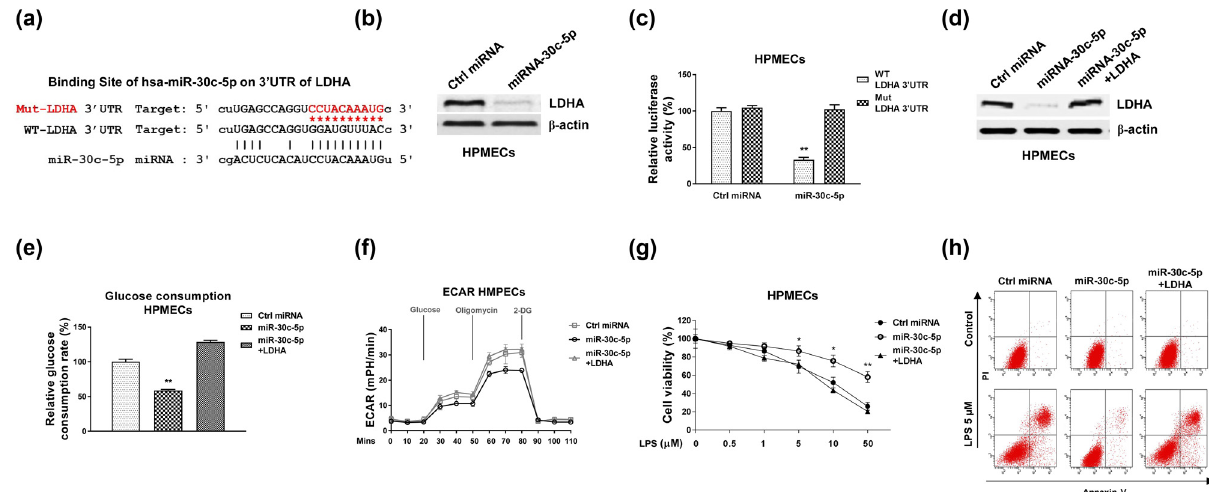
Figure 6: miR - 30c - 5p directly targets LDHA in HPMECs. ( a ) Prediction of the binding of miR - 30c - 5p on 3 ′ UTR of LDHA from starBase. ( b ) HPMECs were transfected with control miRNA or miR - 30c - 5p. Expressions of LDHA were examined by western blot. ( c ) HPMECs were transfected with control miRNA or miR - 30c - 5p with luciferase vector containing WT - or MUT - LDHA 3 ′ UTR. Luciferase assay was performed. ( d ) HPMECs were transfected with control miRNA, miR - 30c - 5p alone, or with LDHA. Expressions of LDHA were examined by western blot. ( e ) The glucose consumption and ( f ) ECAR were examined in the above transfected cells. ( g ) The transfected cells were treated with LPS at the indicated concentrations. Cell survival rates were determined by MTT assay and ( h ) Annexin V apoptosis assay. *, p < 0.05; **, p <